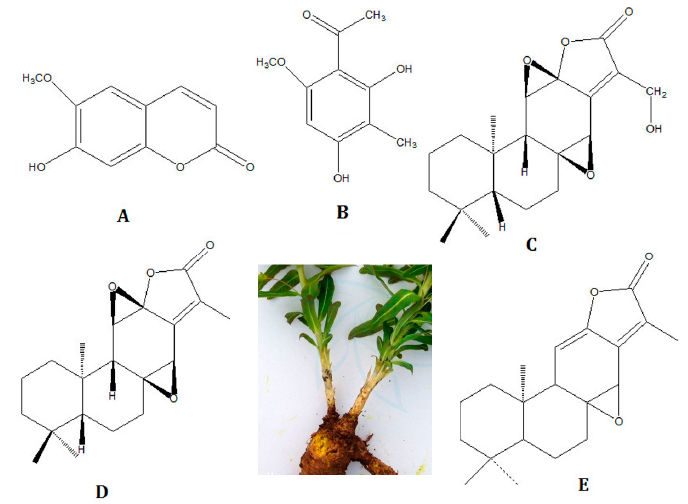
Figure 1. The herb and chemical structures of the five reference substances: Scopoletin ( A ); 2,4-Dihydroxy-6-methoxy-3-methylacetophenone ( B ); 17-Hydroxyjolkinolide B ( C ); Jolkinolide B ( D ); and Jolkinolide A ( E ).